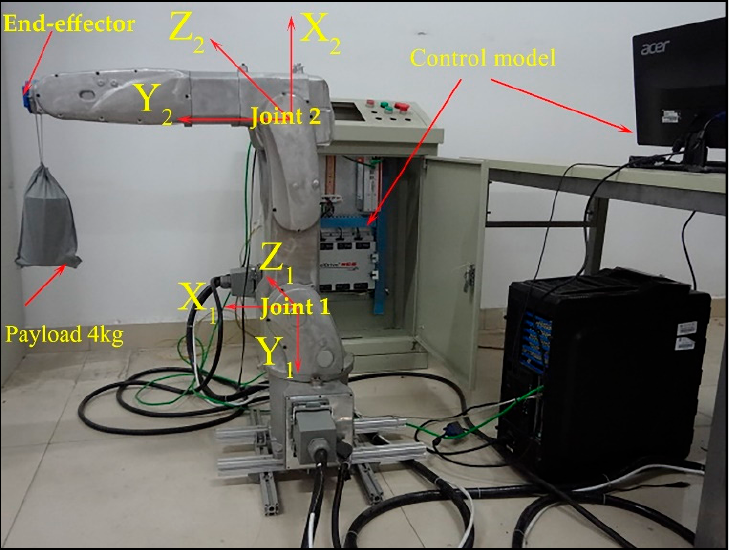
Figure 12. Clarify movement coordinates X in joint 1 and Y in joint 2 at the robot arm in this experiment.